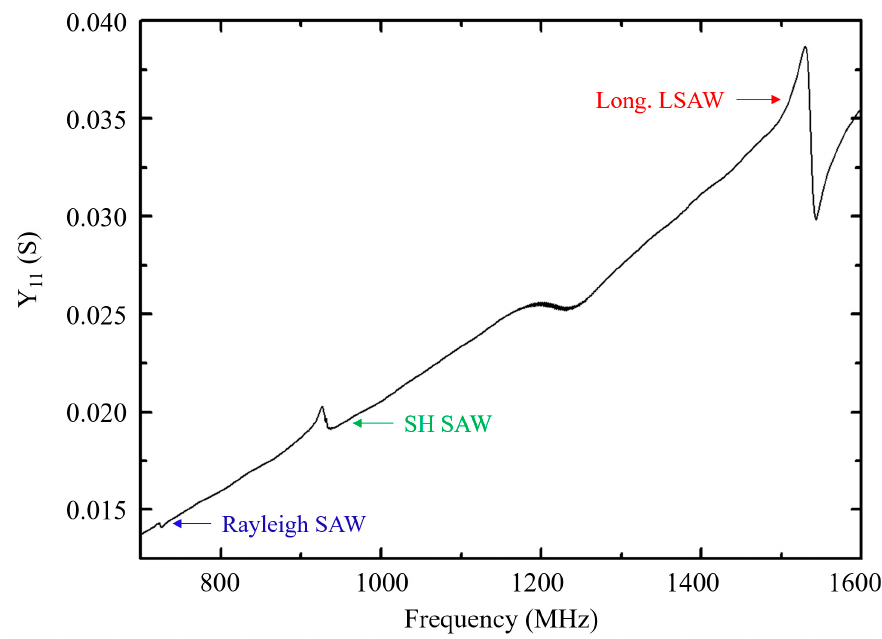
Figure 8. Y 11 response of the SAW resonator based on the Sc 0.09 Al 0.91 N / sapphire bilayer structure, for a film thickness of 2.76 µm and a wavelength of 6.5 µm.